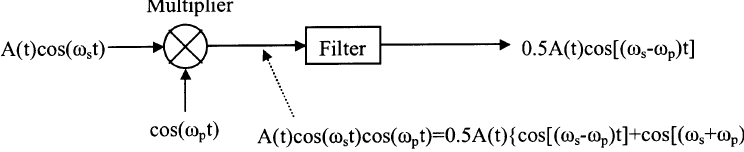
FIGURE 2 A mixer as a